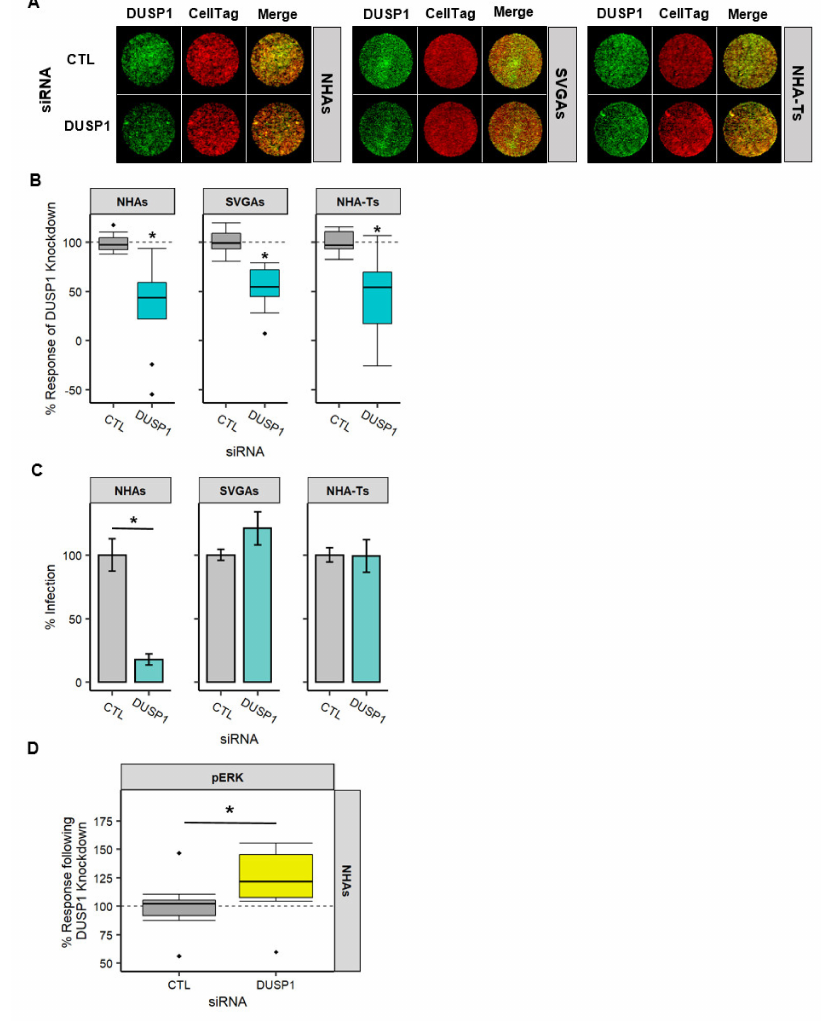
Figure 5. DUSP1 was required for JCPyV infection in NHAs, regardless of pERK expression. NHAs, SVGAs, and NHA-Ts were transfected with DUSP1 or EGFR (CTL) siRNA. At 24 h post-transfection, cells were fixed, imaged, and quantified for protein knockdown ( A , B ) or infected ( C ). ( A ) DUSP1 protein expression was determined by ICW, staining for total DUSP1 (green) or CellTag (red). ( B ) Quantification of DUSP1 protein expression was measured by ICW signal intensity values per [(DUSP1)/Cell Tag × 100% = % response] within each ICW analysis in LI-COR software. Cells treated with DUSP1 siRNA were normalized to the respective EGFR (CTL) siRNA (dashed line). Box and whisker plots represent the distribution of 9 samples, with the median denoted by the black line and whiskers representing values 1.0 times the distance of the inter-quartile range. Outliers are represented by black diamonds. A pairwise Wilcoxon rank-sum test, along with the Bonferroni adjustment, was used to compare CTL and DUSP1 siRNA-treated cells across each cell type. *, p < 0.01. Data are representative of three independent experiments performed in triplicate. ( C ) At 24 h post-transfection, cells were infected with JCPyV (MOI = 1.0 FFU/cell) at 37 ◦ C for 1 h. Cells were incubated in complete media for 48 h then fixed and stained by indirect immunofluorescence. Percent infection following DUSP1 knockdown was determined by quantifying the number of JCPyV T Ag-positive nuclei divided by the number of DAPI-positive nuclei for five × 20 fields of view for triplicate samples. Error bars indicate SD. Student’s t test was used to determine statistical significance comparing EGFR (CTL) siRNA-treated cells to DUSP1 siRNA-treated cells, for each cell type. *, p < 0.01. ( D ) Quantification of pERK expression following DUSP1 siRNA at 24 h post-transfection was measured by ICW signal intensity values per [(pERK)/Cell Tag × 100% = % response] within each ICW analysis in LI-COR software. Cells treated with DUSP1 siRNA were normalized to the EGFR (CTL) siRNA (dashed line). Box and whisker plots represent the distribution of 9 samples, with the median denoted by the black line and whiskers representing values 1.0 times the distance of the inter-quartile range. Outliers are represented by black diamonds. A Wilcoxon rank-sum exact test was used to compare CTL and DUSP1 siRNA-treated cells. *, p <